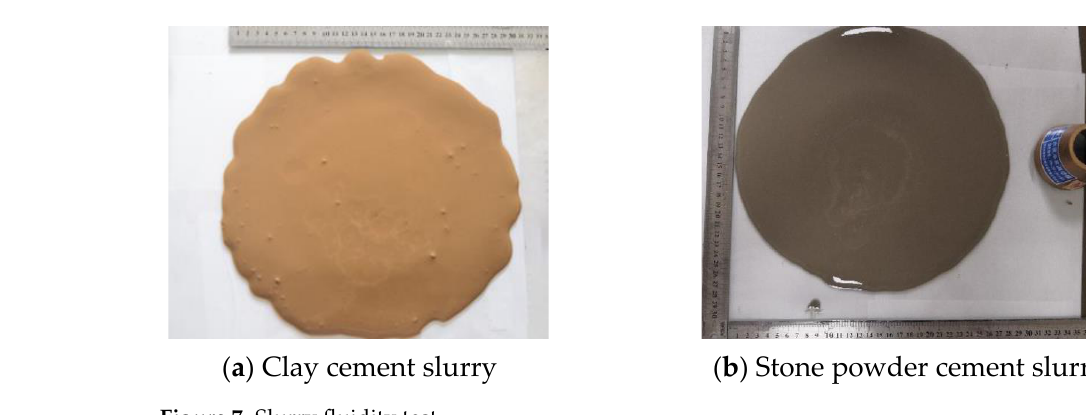
Figure 7. Slurry fluidity test.